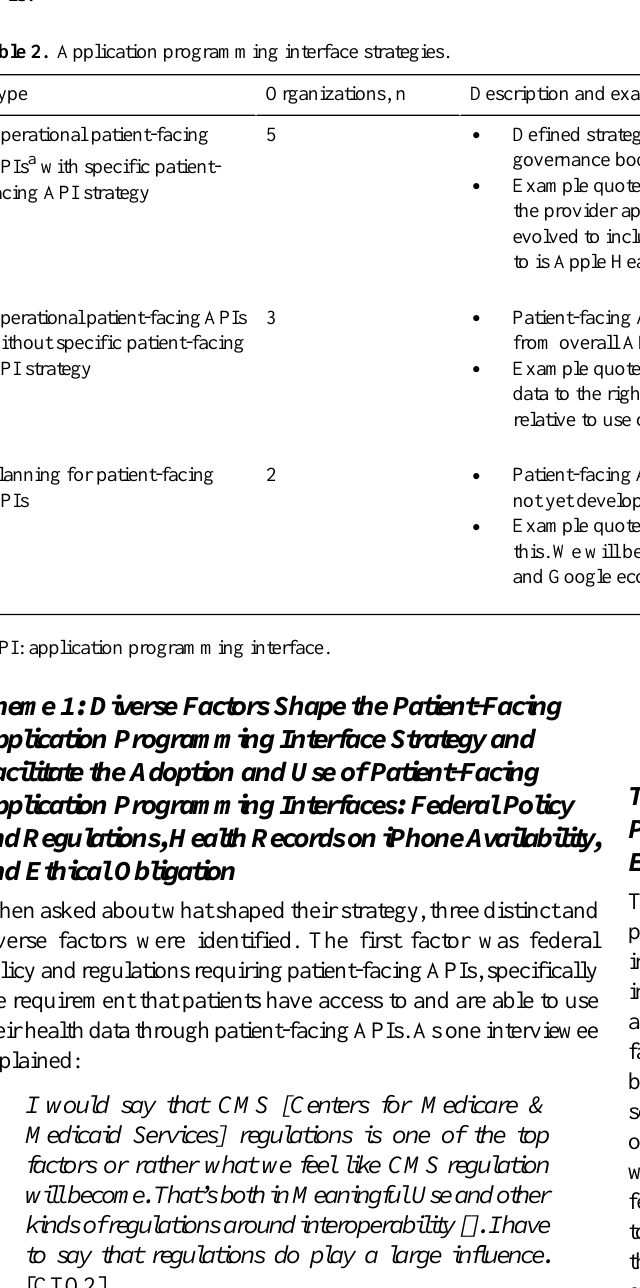
Table 2. Application programming interface strategies.